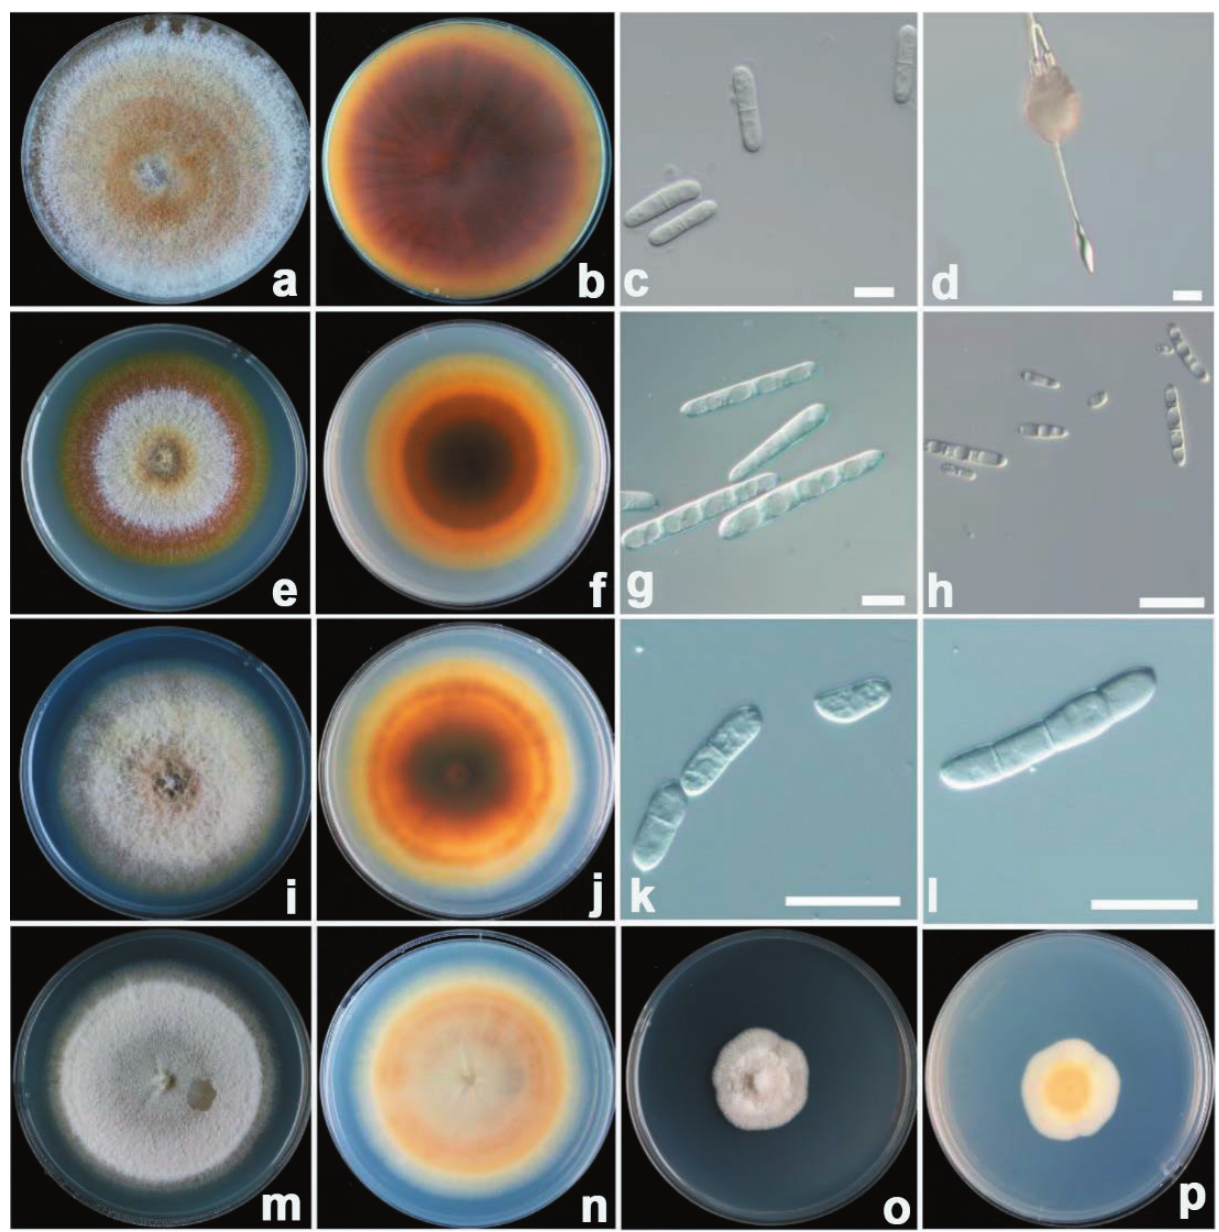
Figure 4. Photographs of isolated fungi and their morphological characterization. Colonies (top and bottom views of cultures) of Cylindro- cladiella lageniformis ( a and b ), Dactinonectria macrodidyma ( e and f ), D. torresensis ( i and j ), D. alcaceresis ( m and n ), or Neonectria sp.1 ( o and p ). Conidia and terminal vesicles of C. lageniformis ( c and d ). Conidia of D. macrodidyma ( g and h ), and D. torresensis ( k and l ). All the fungi were grown on PDA for 14 d. Bars = 10 μm ( c and d ) or 20 μm ( g, h, k and l